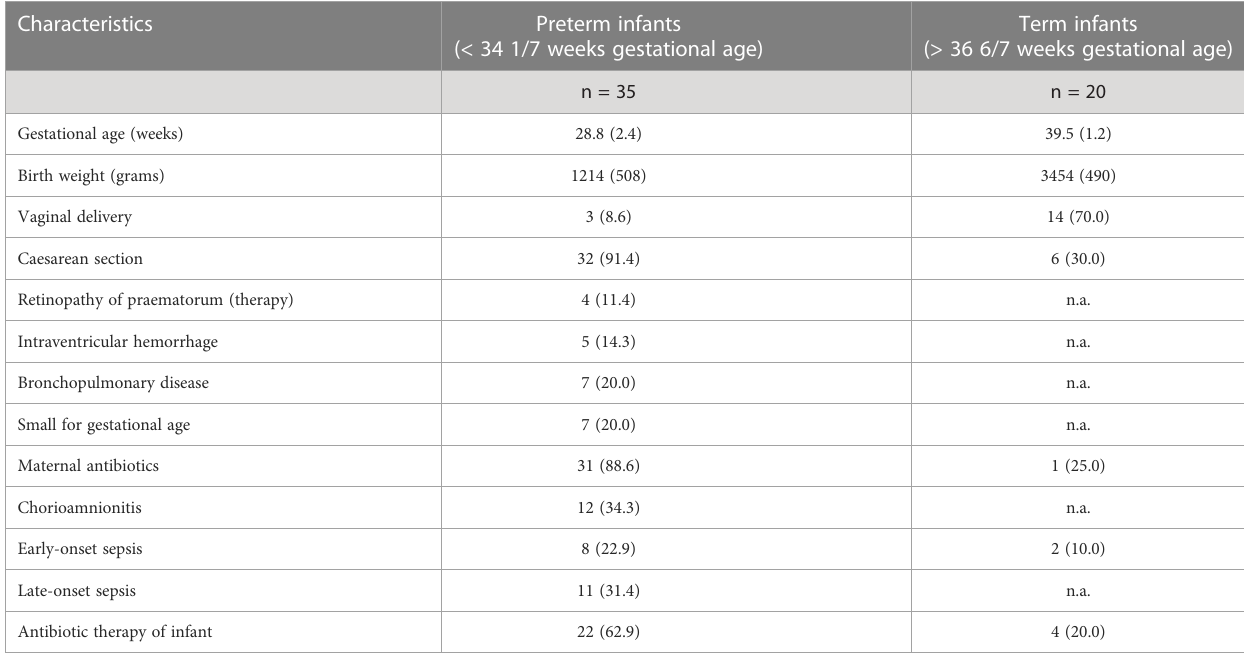
TABLE 1 Baseline characteristics of included preterm and term